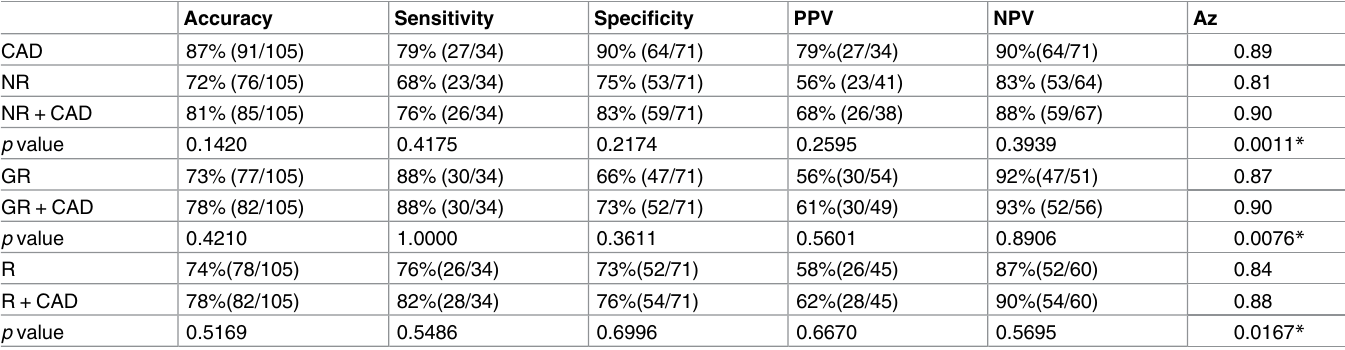
Table 1. Three radiologists’ performances of the first diagnosis and a subsequent assessment with computer-aided diagnosis (CAD) in the classi- fication of low-grade gliomas (LGGs) and glioblastomas (GBMs). Accuracy